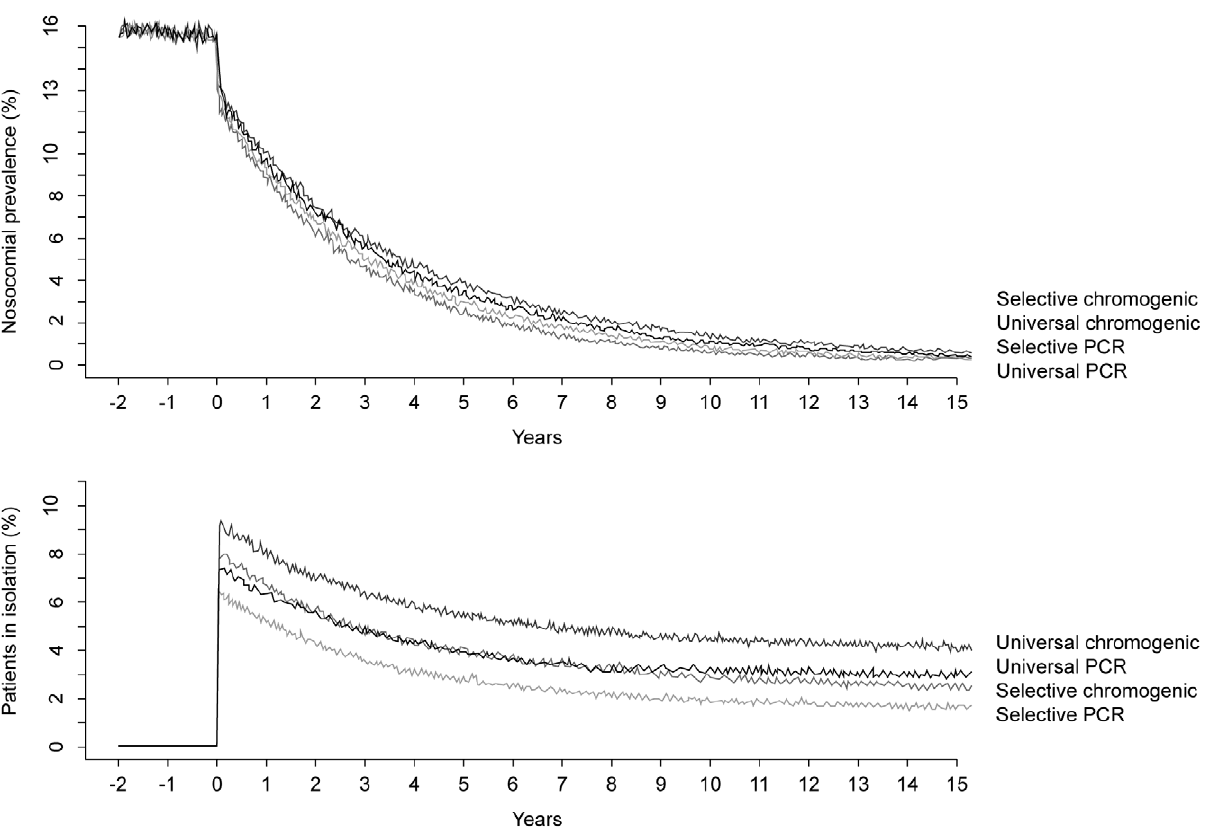
Figure 1. Nosocomial prevalence and patients in isolation over time. The upper graph shows the impact of the screening strategies on the nosocomial prevalence over time. The lower graph shows the percentage of total patients in isolation over time for each strategy. Both graphs show the mean of 1000 runs of the model.